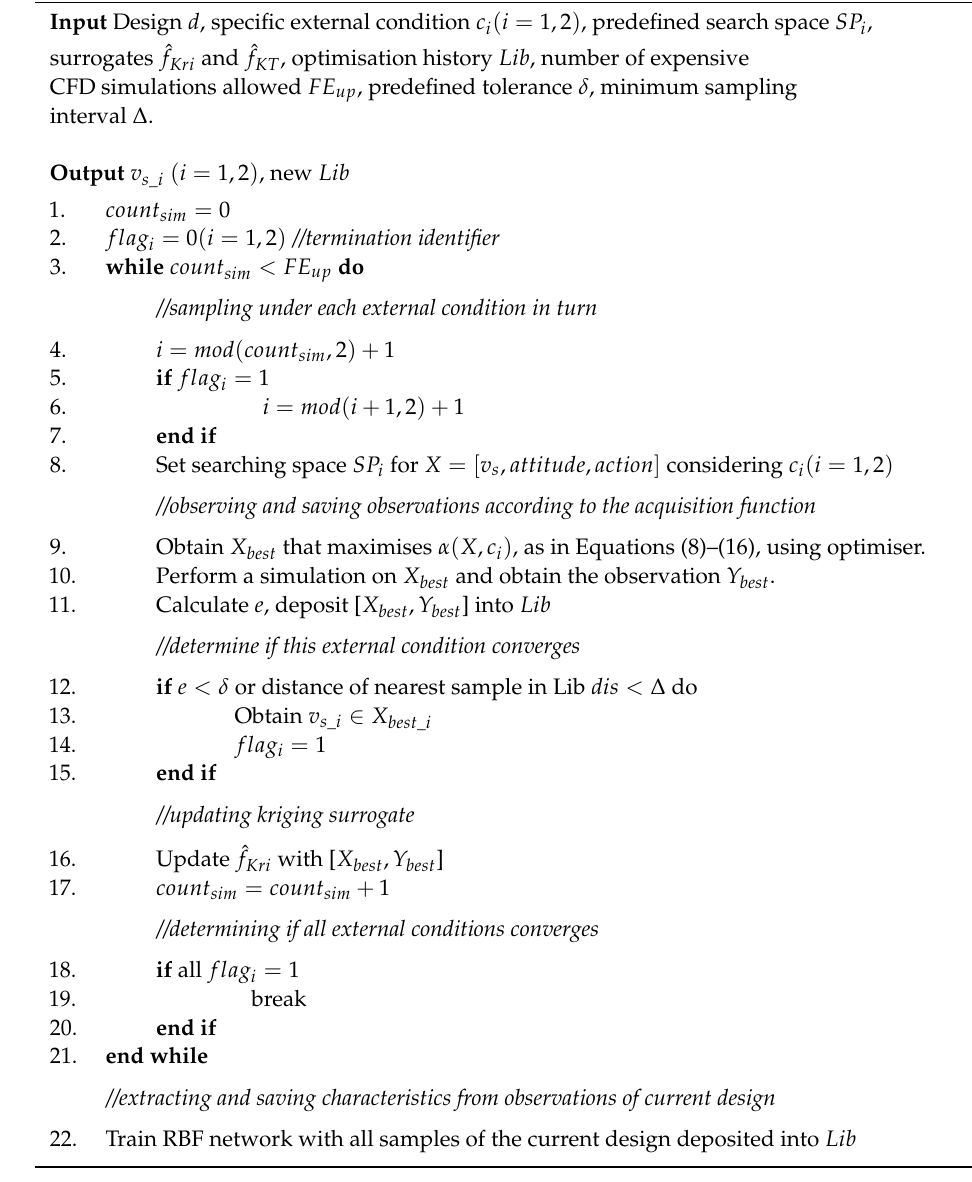
Algorithm 2 Pseudo code for update